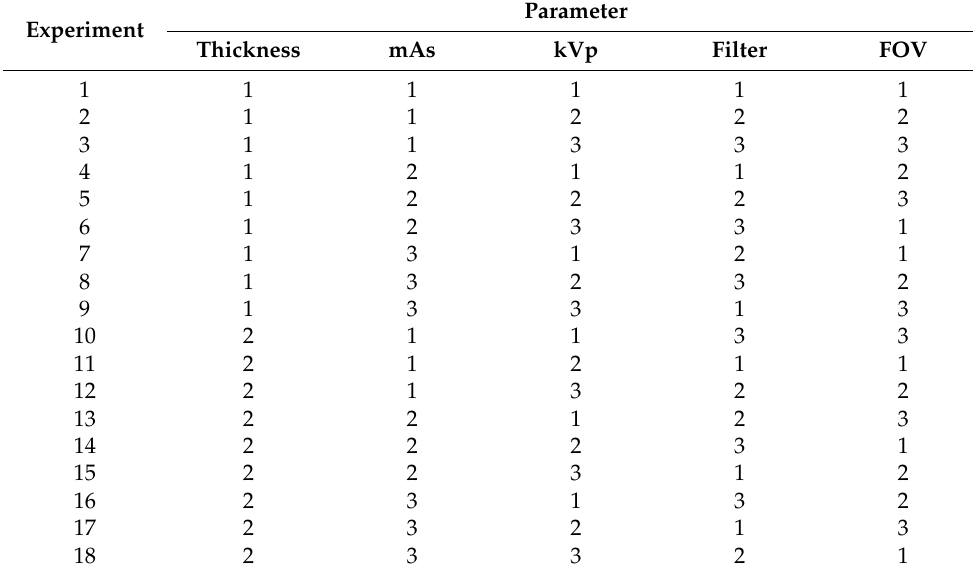
Table 2. Full Taguchi design with L 18 (2 1 × 3 4 ) orthogonal